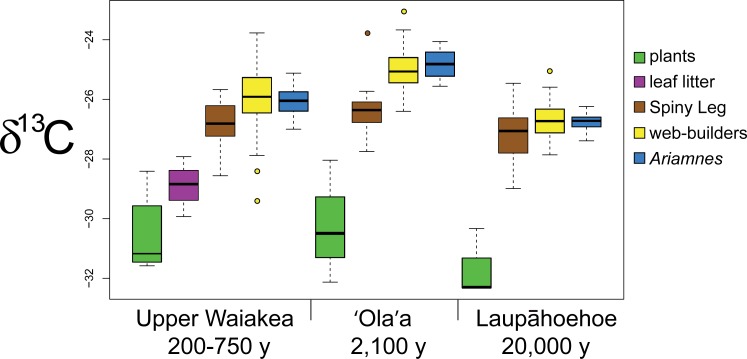
Boxplots showing carbon isotope ratios of functional groups across sites.Carbon isotope ratio (δ13C in ‰  units) of plant leaves (green), leaf litter (purple), Spiny Leg (brown), web-building (yellow) and Ariamnes (blue) spiders across sites of different ages.